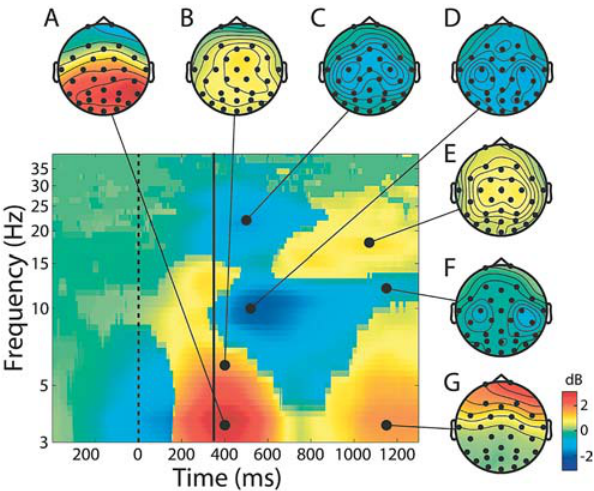
Figure 3. Changes in Mean Scalp Spectral Power Time-Locked to the Subject Response The solid vertical line indicates moment of the motor response (shown at the grand mean subject median RT, 352 ms). Color scale: decibel change from prestimulus baseline. Image shows signed-RMS power changes across all 29 scalp channels prior to removal of all but the largest eye artifacts. Scalp maps show the scalp topography of the spectral power change in decibels relative to baseline. Note (A and B) the broad posterior low-theta- and anterior higher-theta-band maxima at the button press, (C, D, and F) the bilateral central alpha and beta blocking, (E) the central lateral postresponse beta increase, and (G) the increase in low-frequency eye artifacts at the end of